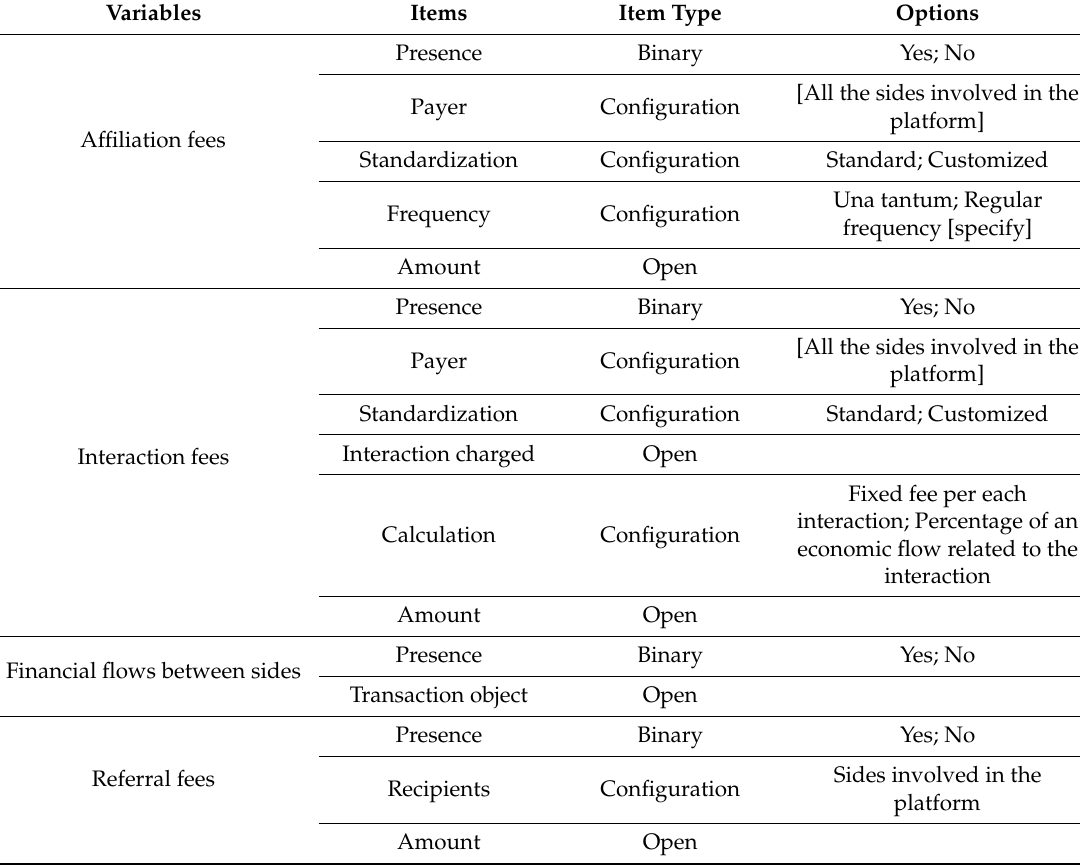
Table 7. Variables, items and configuration options for the “platform revenue model”